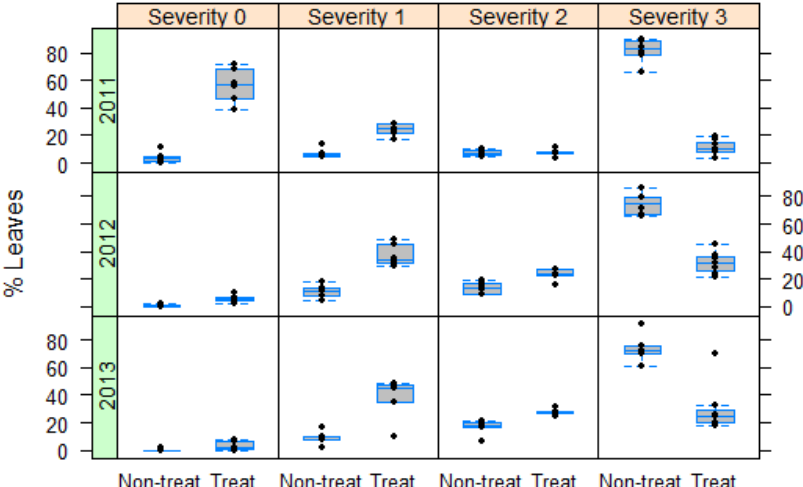
Figure 2. Box-whisker plots of percentages of leaves in the categories of greasy spot severity observed in trees treated with fenbuconazole and the non-treated control in experiment 1 on ’Star Ruby’ grapefruit at Tambo, Panama, from 2011 to 2013 (0 = no lesions; 1 = 1–10 leaf spots; 2 = 11–20 leaf spots; 3 = more than 20 leaf spots). Three sprays of fenbuconazole were applied in 2011 and one spray in 2012 and 2013.